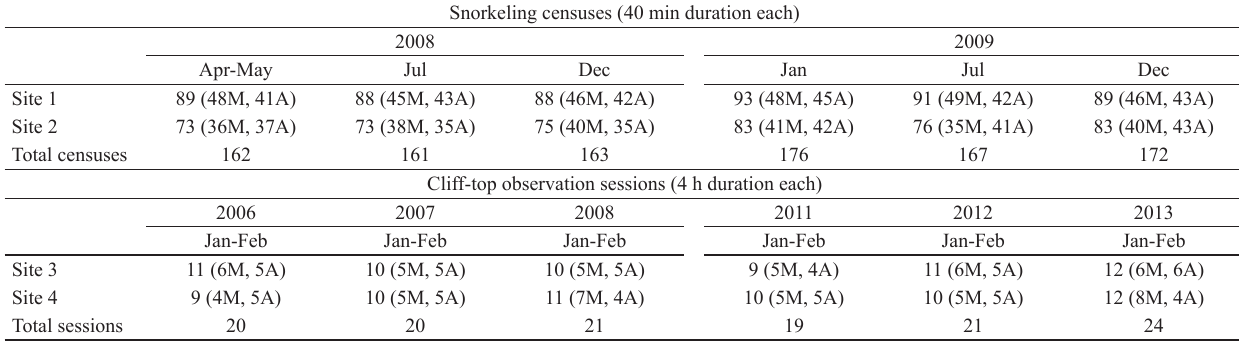
Tab. 1. Sampling effort per period of the diel cycle in the Fernando de Noronha Archipelago, Brazil. * M = morning (06:00 to 12:00 h); A = afternoon (12:01 to 18:00 h); Wet season (from February to July), Dry season (August to